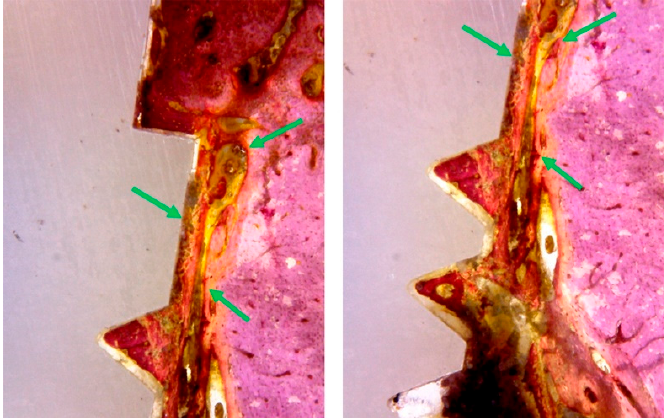
Figure 9. Histological images of the Zr group shows the bone to implant contact and the presence of collagen fibers and less intense density of the bone tissue around the surface (green arrows).